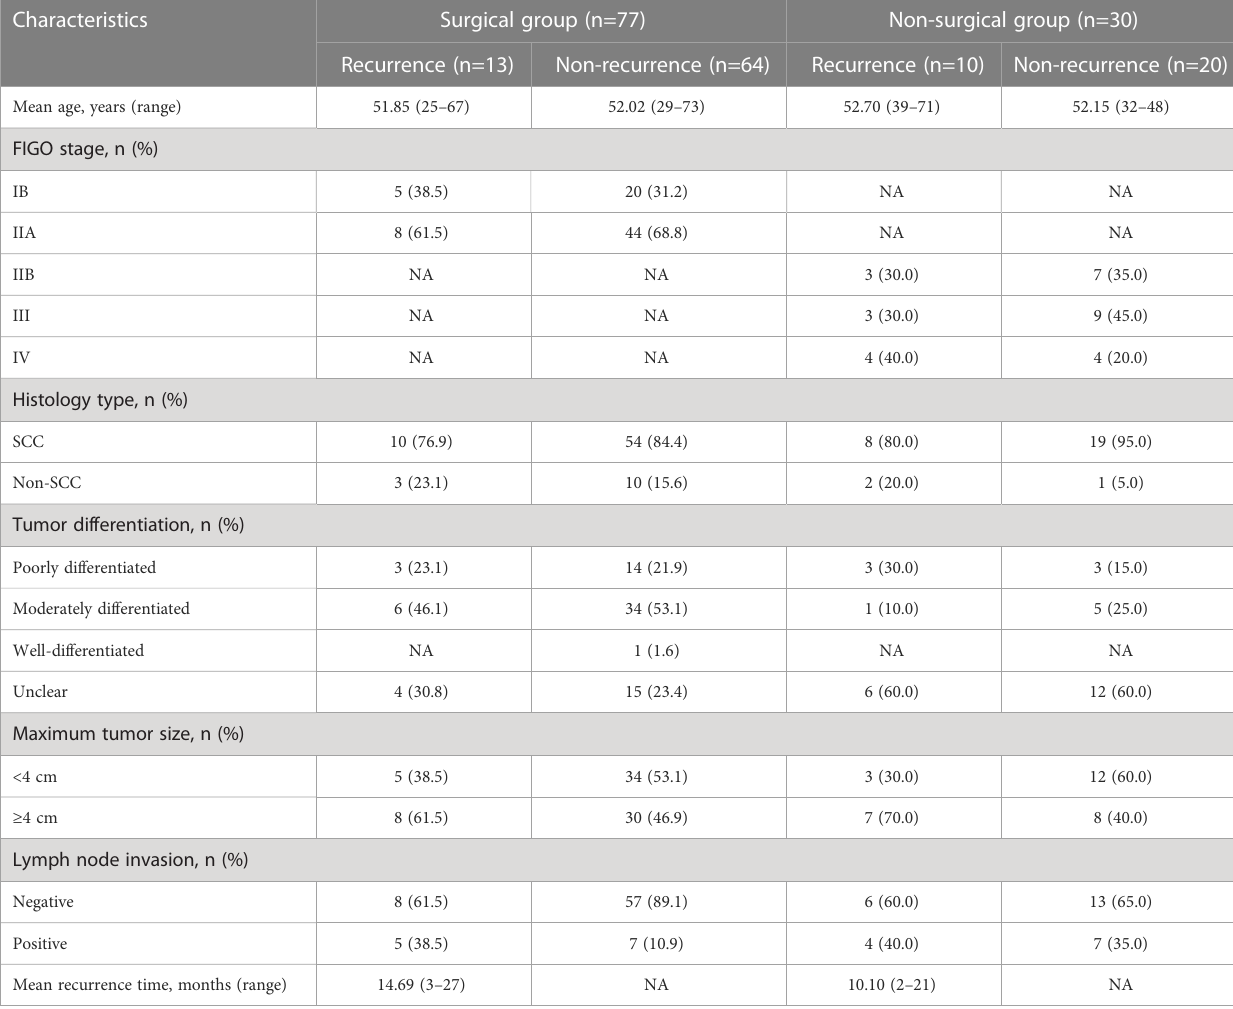
FIGO, International Federation of Gynecology and Obstetrics; NA, not available; SCC, squamous cell